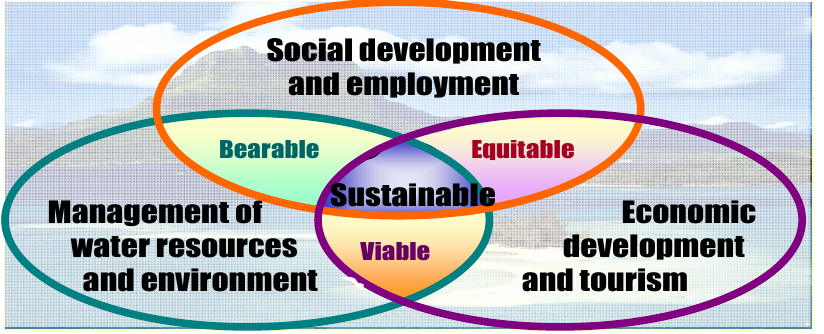
Figure 1. The concept of sustainable development of the municipality of Bora Bora.